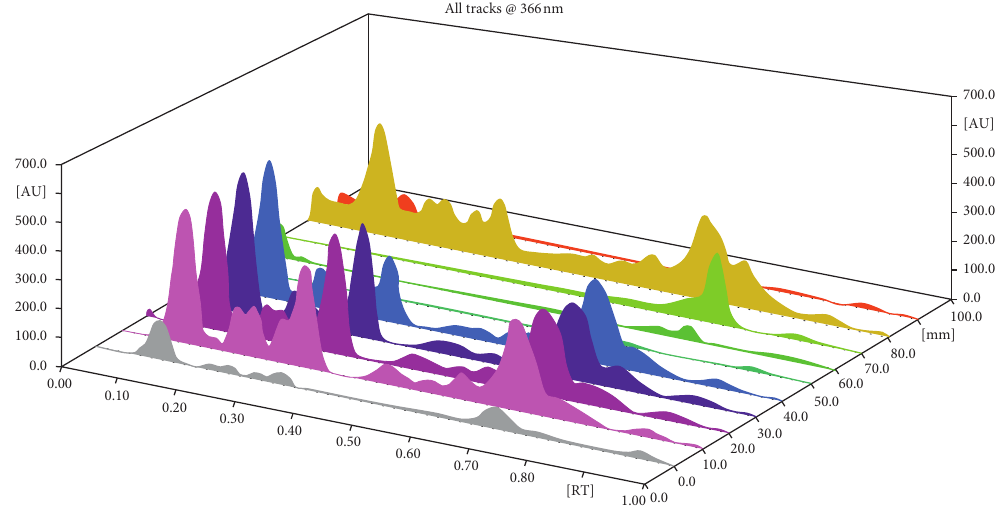
Figure 7: 3D graph of the HPTLC